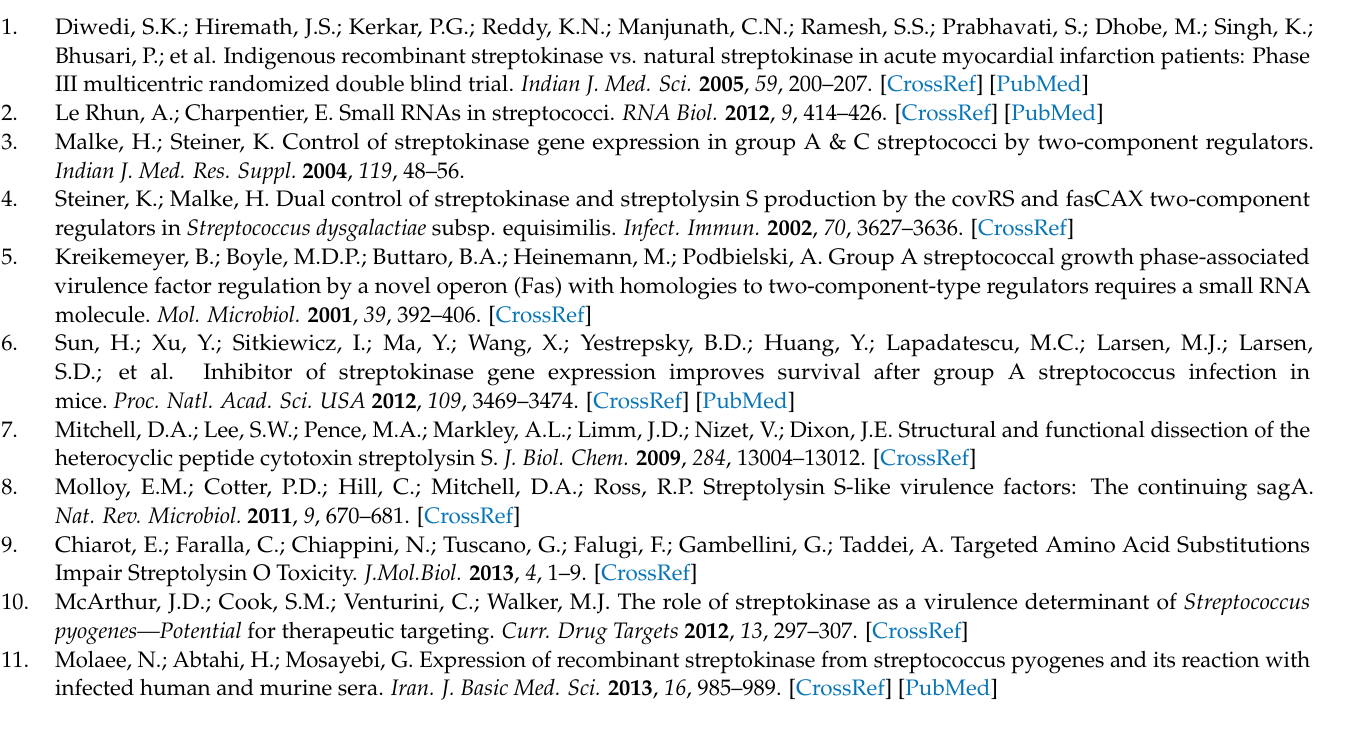
Figure S3: CRISPR-Cas9 system for knockout; Figure S4: Screening and identification of knockout clone; Figure S5: Sequence alignment of SagBCD complex with wild-type E. coli MCB complex; Figure S6: Streptokinase standard is available as STPase, produced by Cadila pharmaceuticals; Table S1: List of all the organisms used in the study; Table S2: List of primer and gRNAs sequences used in this